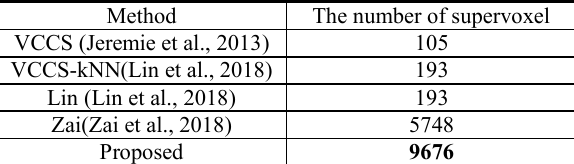
Table 1. The information of our tested scenes